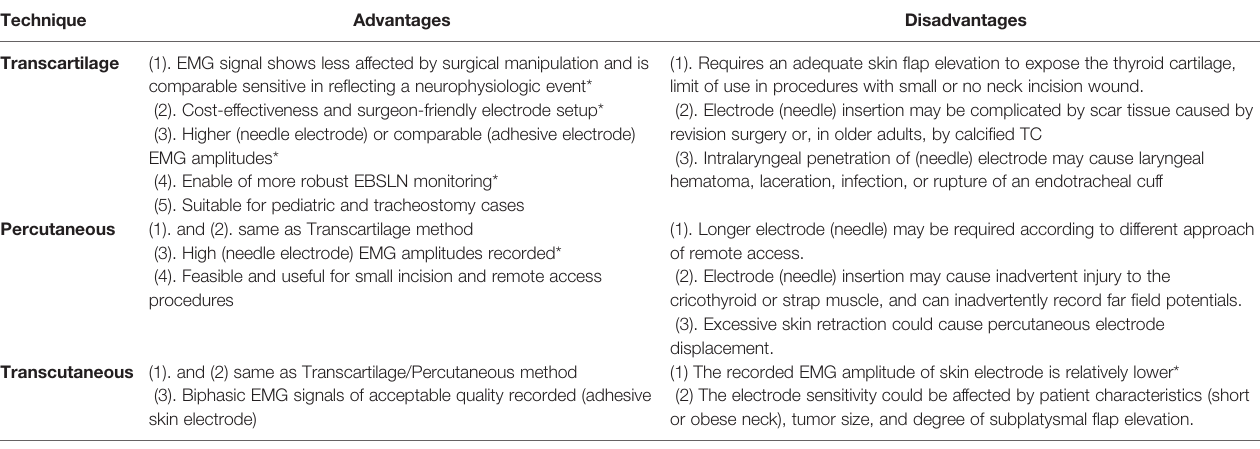
Technique Advantages Disadvantages